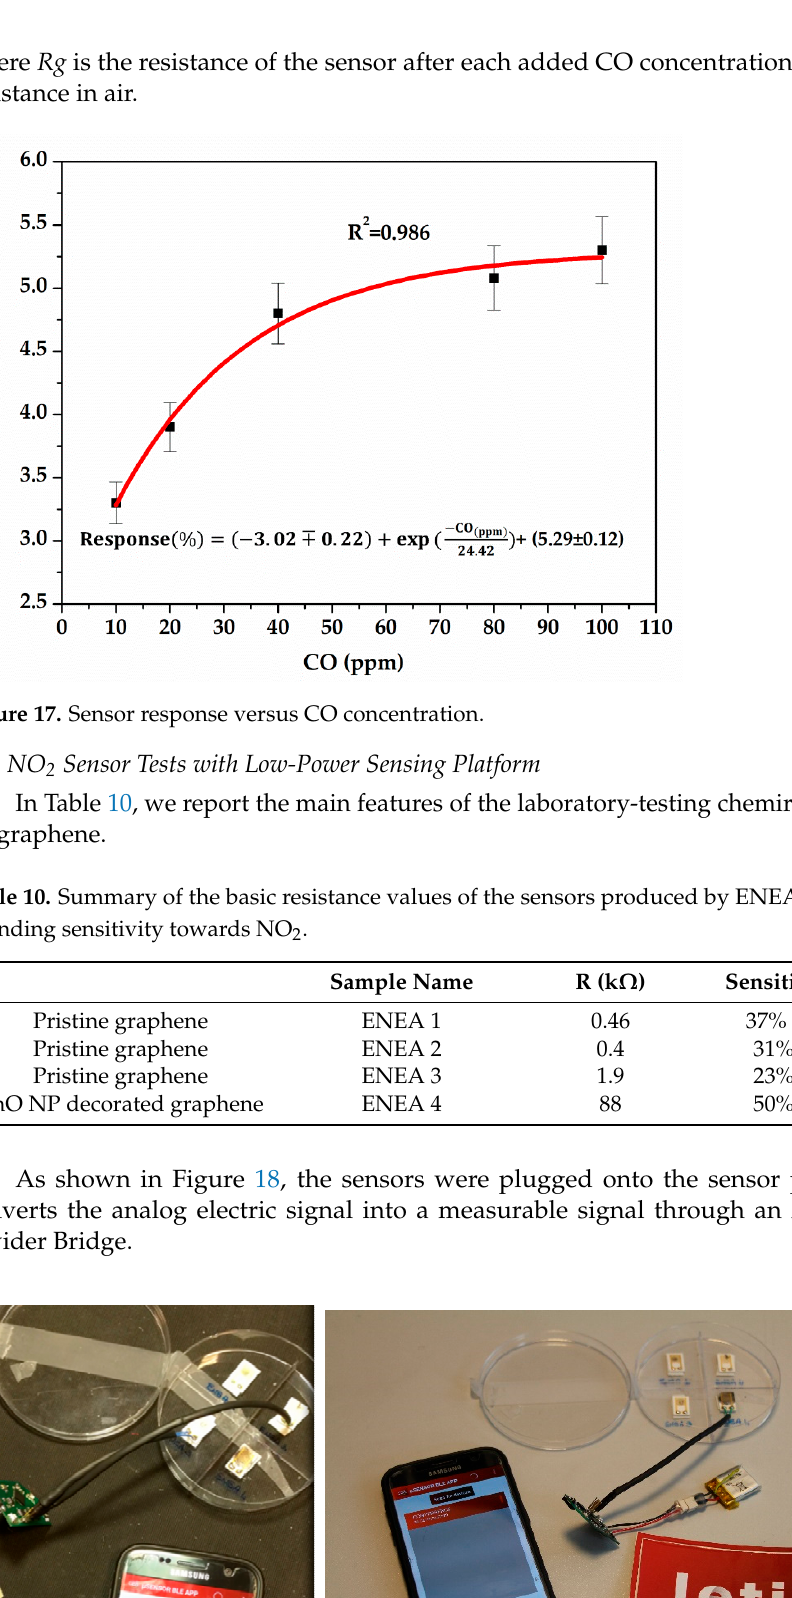
Table 11. Summary of the main electrical parameter checked after the connection to the CEA-LETI platform .